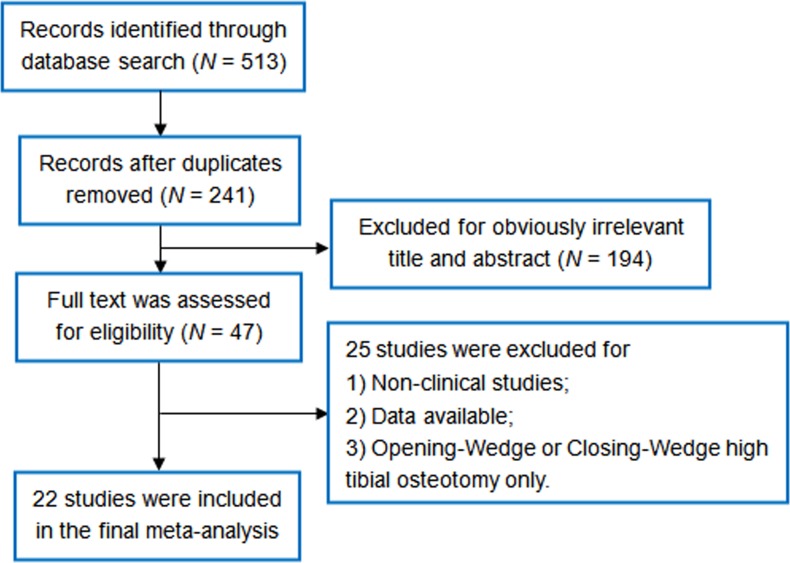
Flow diagram of the identification and selection of the studies included in this meta-analysis.